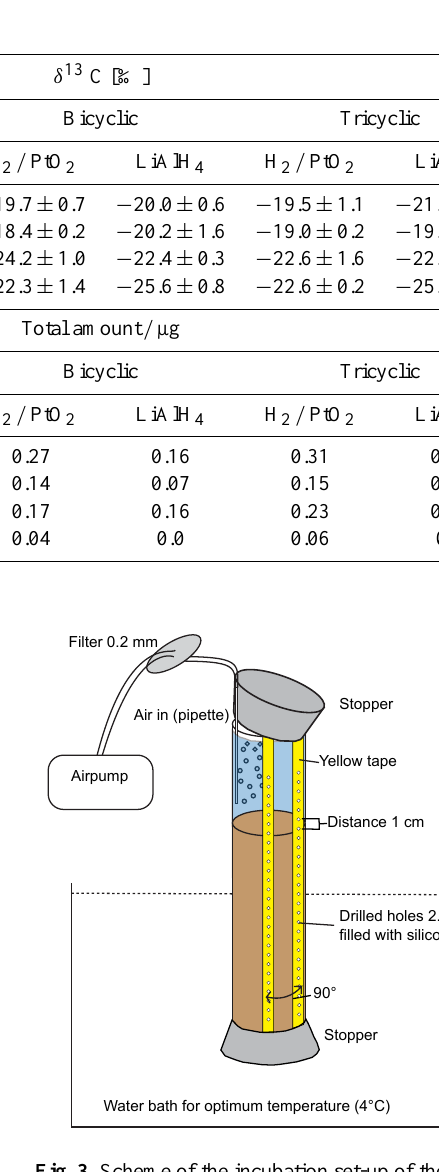
Fig. 3. Scheme of the incubation set-up of the